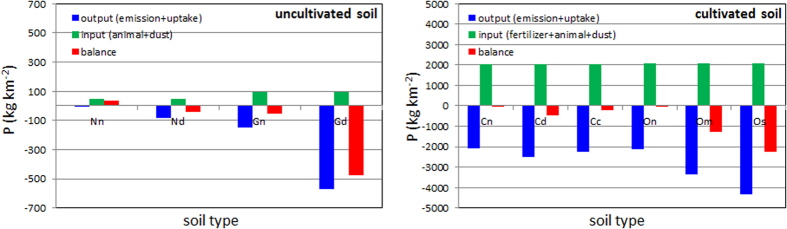
Balance of P amounts per year (kg km−2) in the topsoils.A–balance for natural reserve (Nn) and open grazing area (Gn) with the impact of a short-term disturbance of the topsoil (Nd and Gd). B–balance for crop fields under organic (On-no grazing, Om-medium grazing, Os-strong grazing) and conventional (Cn-no tillage, Cd-disk tillage, Cc-cultivator tillage). Note the differences in the scale values of Y axes.